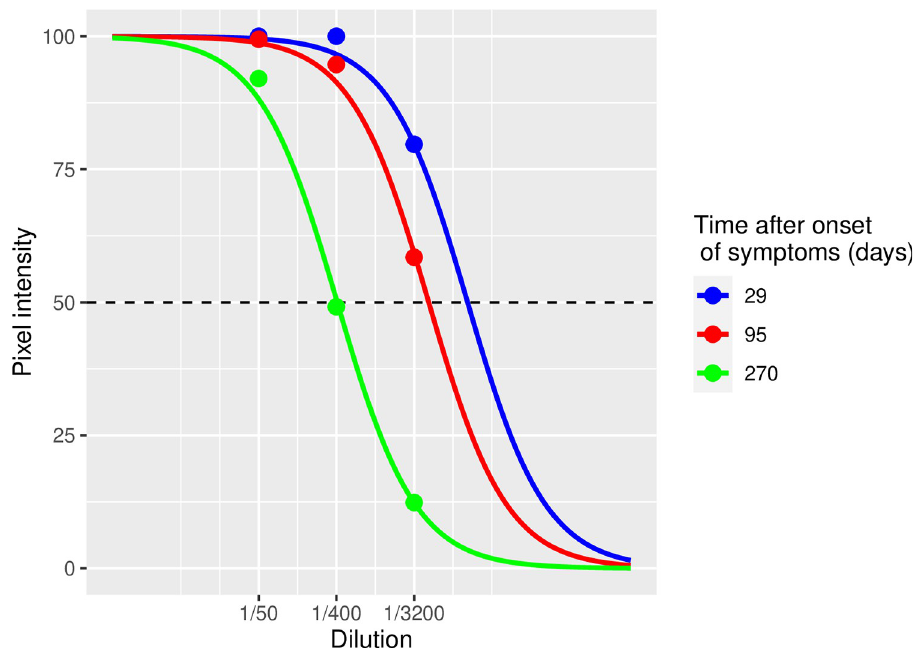
Fig 2. Sigmoidal curve fitting example. Sigmoidal curve fitting of 3 dilutions (1/50, 1/400, 1/3200) for 3 timepoints of the naturally infected subject #6 for the anti-RBD antibodies.